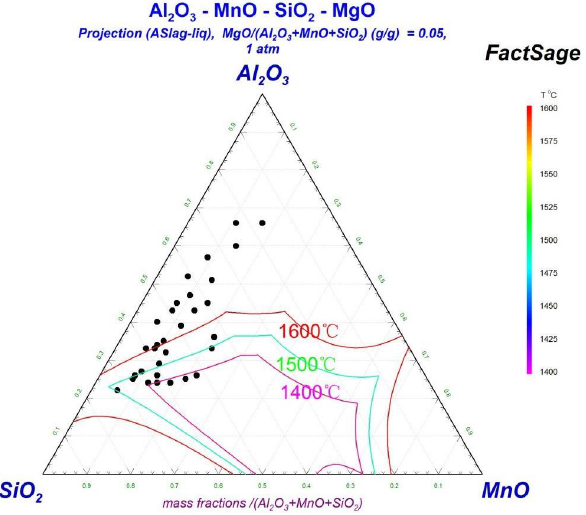
Figure 4: Composition distribution of inclusions in Al 2 O 3 -SiO 2 -MnO phase diagrams for